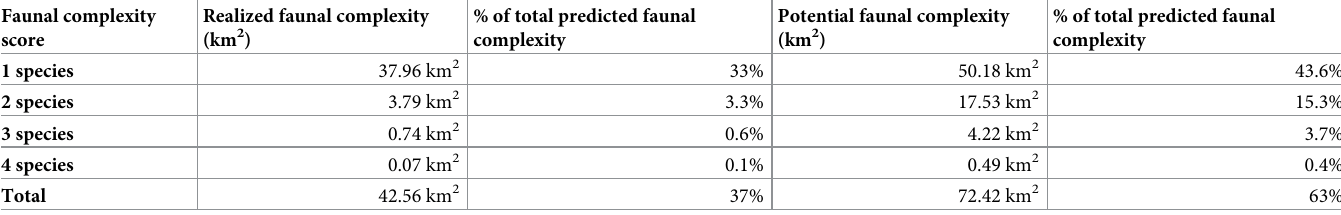
Table 3. Realized and potential faunal complexity